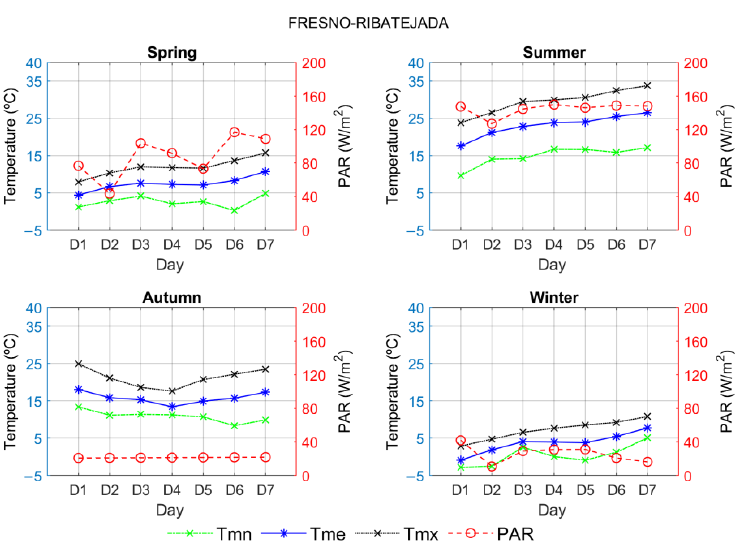
Figure A1. Daily variations of the daily mean values of temperature (mean, max, and min) and PAR for the selected TMWs for each season in Fresno-Ribatejada from 1991 to 2005.